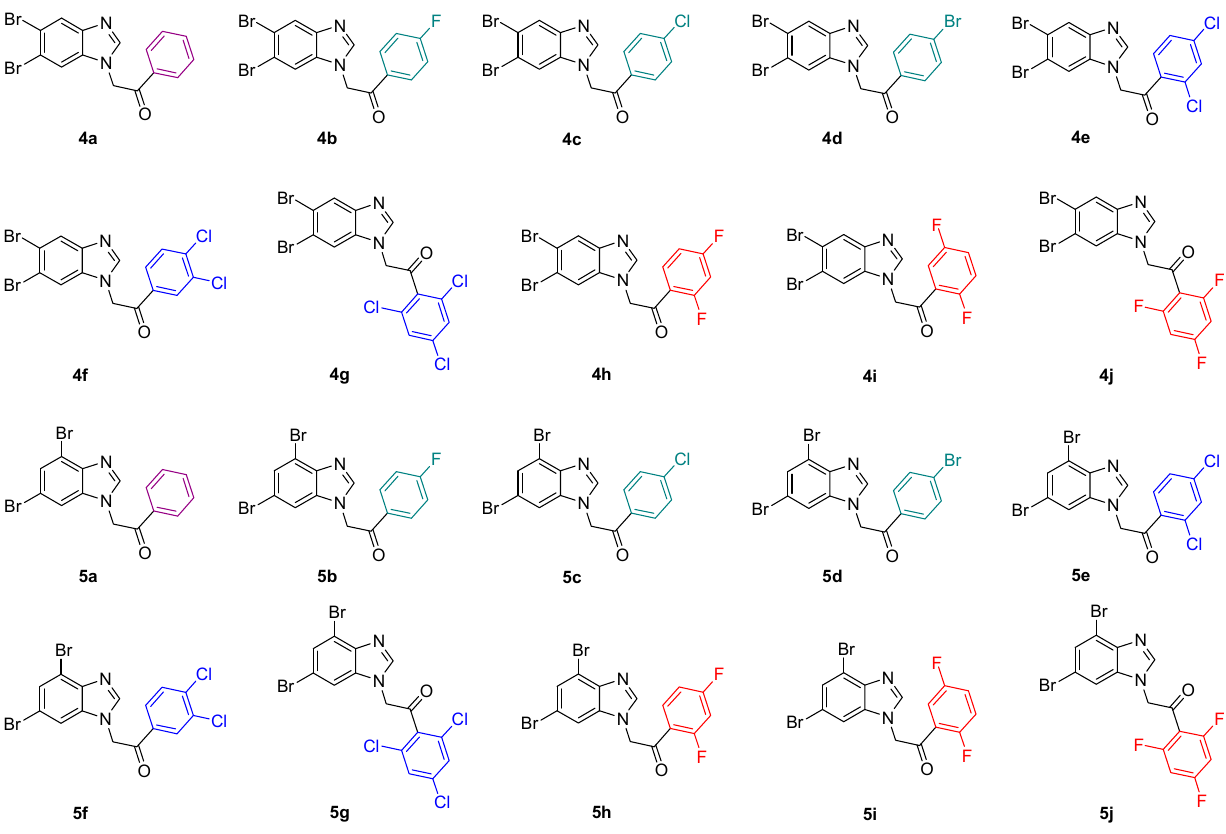
Scheme 3. Structures of the synthesized N -phenacyldibromobenzimidazoles 4 and 5.